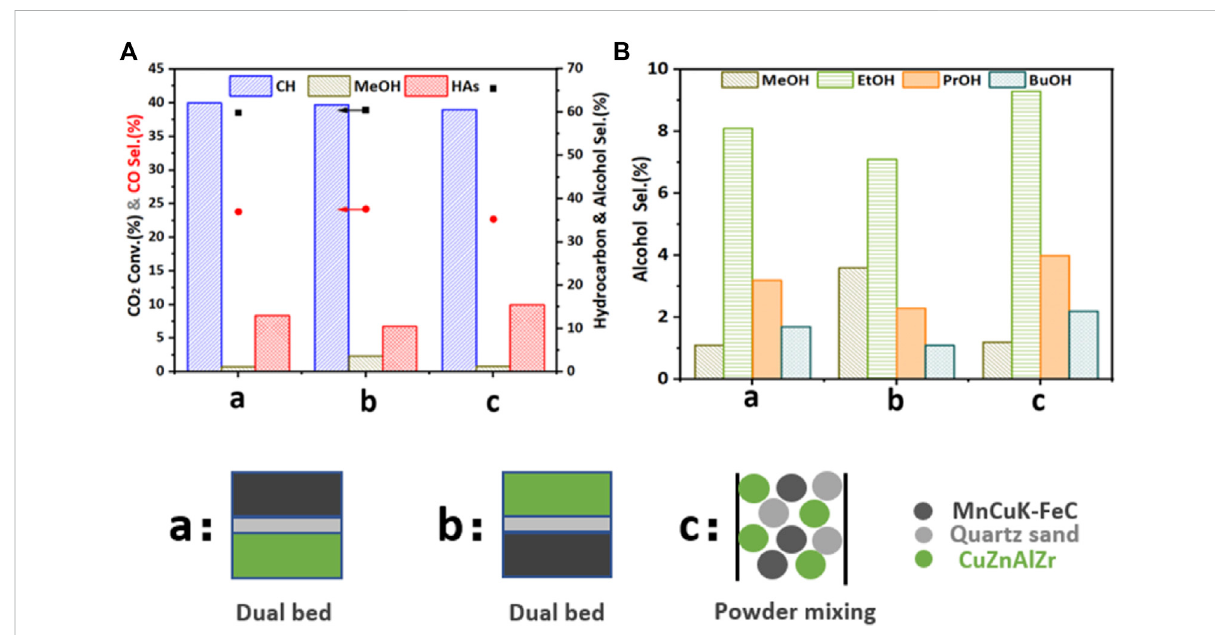
FIGURE 5 ResultsofCO 2 hydrogenationperformedondifferentcatalyst fi llingmethods. (A) CO 2 conversionandselectivityofCH,MeOH,HAsandCO. (B) Selective distribution of different alcohol products. (The mass ratio of MnCuK-FeC and CuZnAlZr in different fi lling methods is 1:1) Reaction conditions: 3 MPa, 300 ° C, 6000 ml h − 1 · g cat − 1 , H 2 :CO 2 =